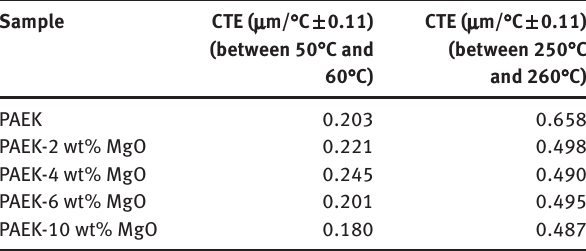
Table 3: Coefficient of thermal expansion (CTE) of PAEK-MgO nanocomposites.